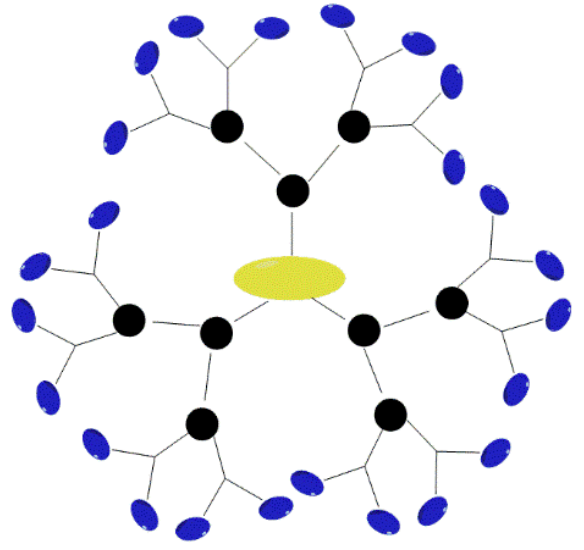
Figure 3. Typical structure of a peptide dendrimer.